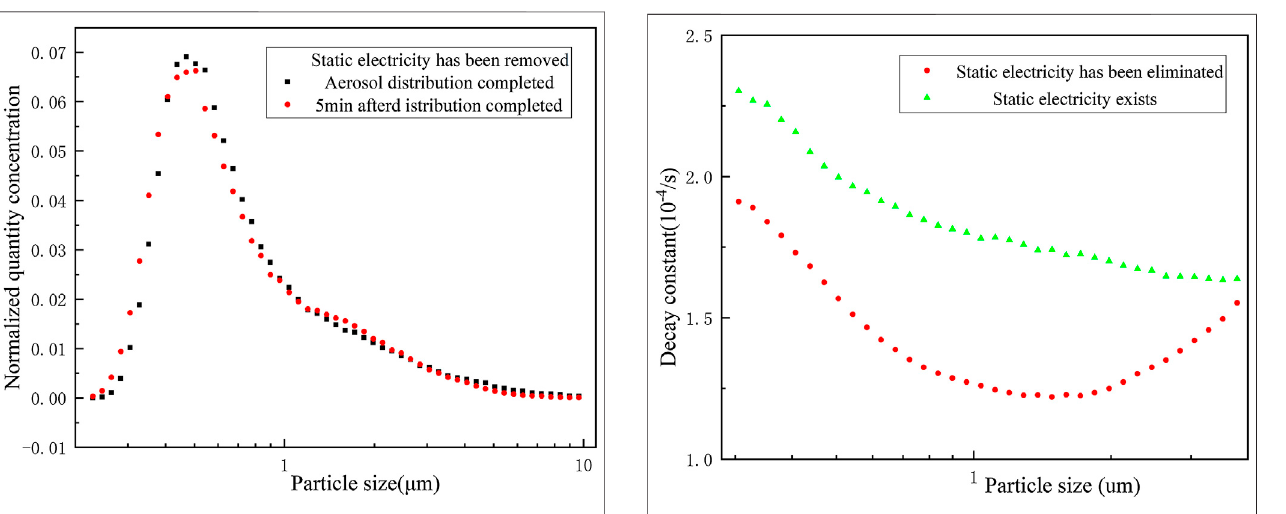
FIGURE6| Effectofstaticelectricityonthedecayconstantofthenatural deposition of erosols with different particle